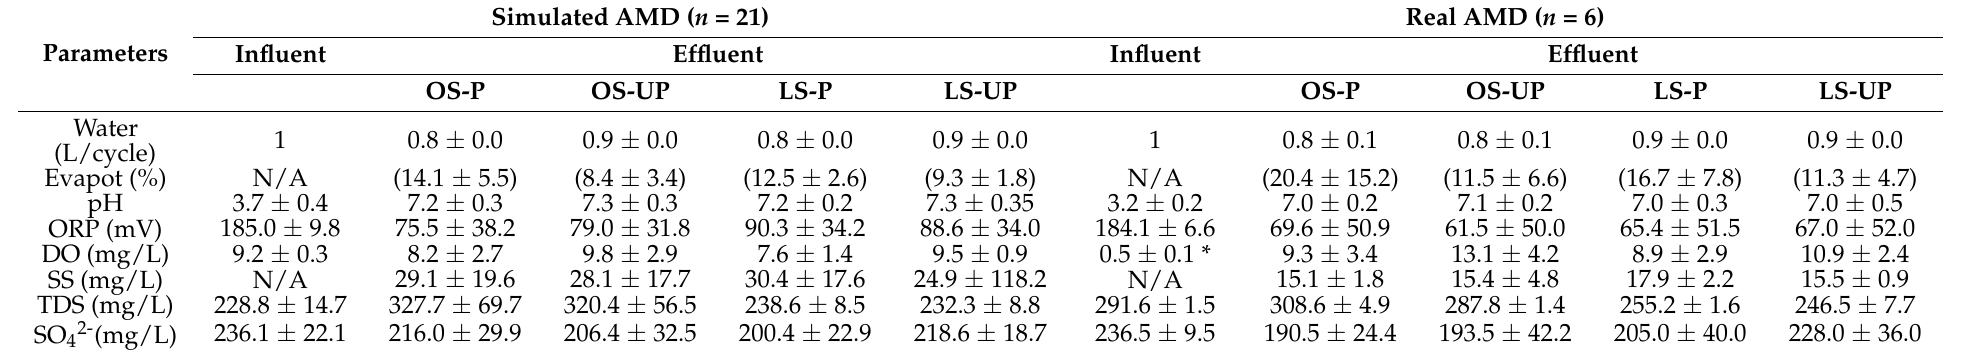
Table 2. Evapotranspiration (Evapot) and water parameters of influent and effluent for CWs in 7-month AMD treatment (avg ±